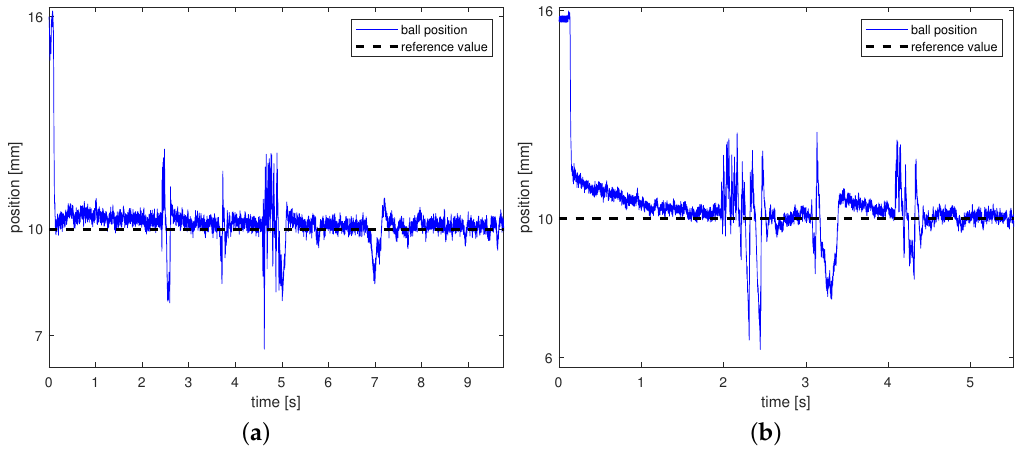
Figure 7. ( a ) Ball position stabilization process with disturbance for the controller tuning by the analytic method, ( b ) ball position stabilization process with disturbance for the controller tuning by the SA method. ( a ) shows the behavior of the control system with controller tuning by the analytic method for external disturbances. The ball in the vicinity of 2.5 s, 5 s, and 7s seconds is knocked out of the working point by a manual interaction. In each case, we see that the control system eliminates the disturbances. ( b ) shows the process of stabilizing the position of the ball under the electromagnet with controller tuning by SA method. The regulation time is approx. 2 s. There is no overshoot here. When the working point is reached, vibrations are noticeable in its